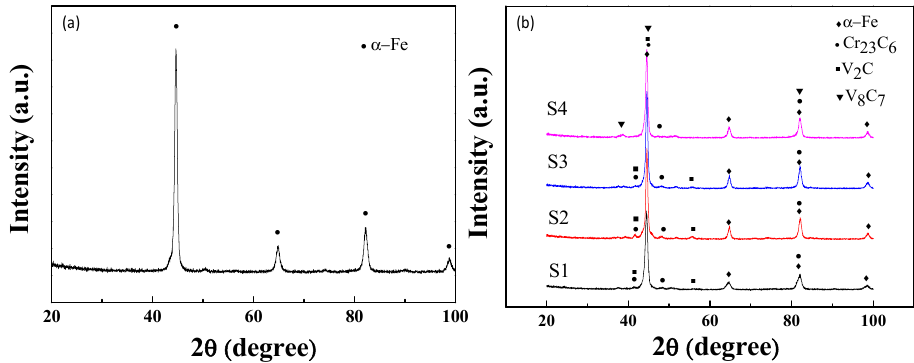
Figure 3. X-ray diffraction spectra of Fe-based alloy gradient materials by LMD ( a ) 12CrNi2V low alloy steel; ( b ) wear-resistant Fe-based alloys.